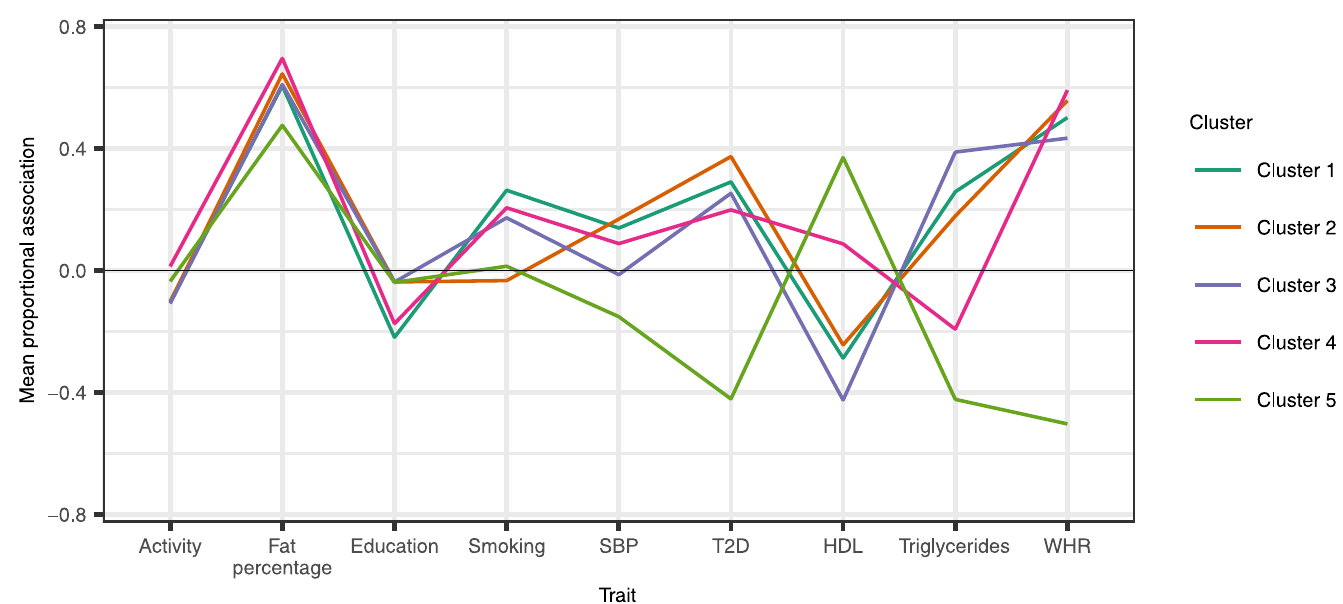
Fig 4. Parallel plot of the mean vector of the fitted von Mises–Fisher distribution for each cluster. The plotted points represent the standardised proportional association with each trait for an observation at the centre of each cluster.